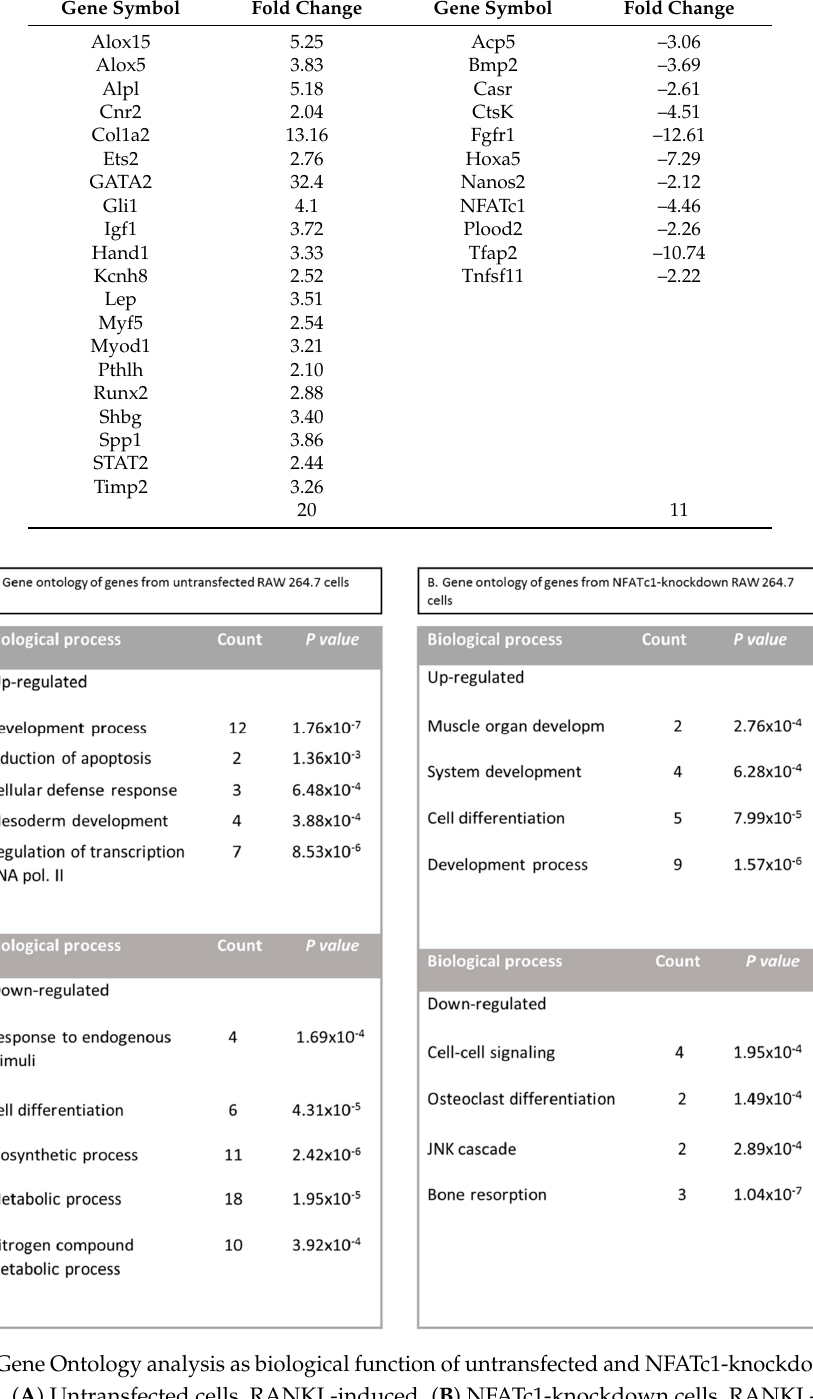
Figure 3. Gene Ontology analysis as biological function of untransfected and